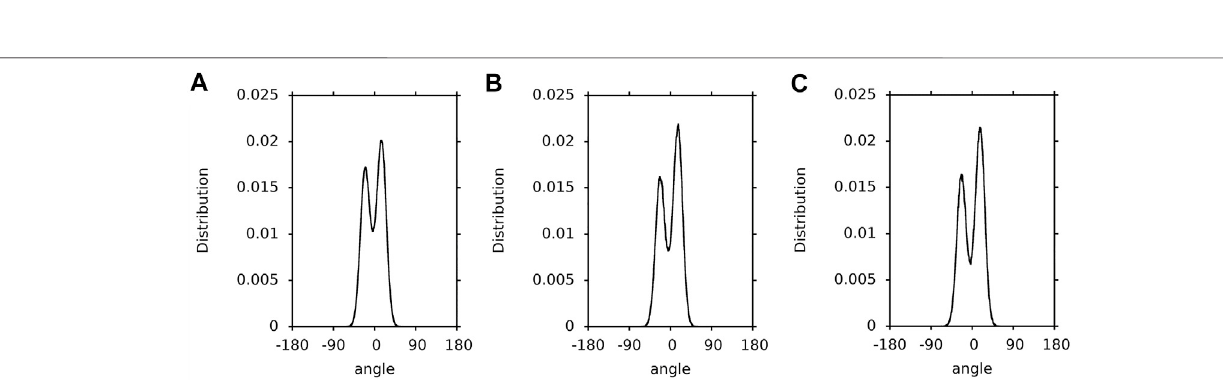
FIGURE 4 | Population distributions of the lutein C5-C6-C7-C8 torsion angles ( β -ring torsion). (A) in the PC-LUT bilayer; (B) in water; (C) in vacuum.